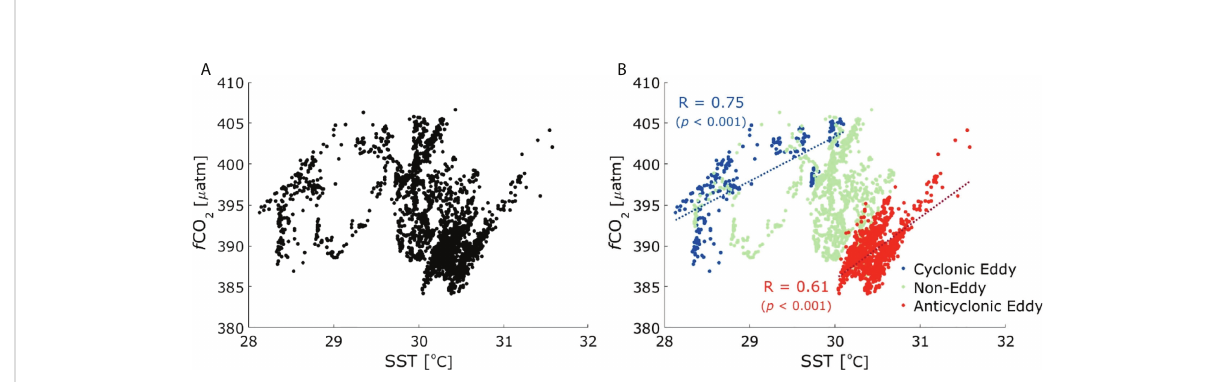
FIGURE 4 Plots of f CO 2 vs. SST in the study region (A) and three subregions (B) ; cyclonic eddy, anticyclonic eddy, and non-eddy. Blue dots indicate a cyclonic eddy, green dots are non-eddy region, and red dots are an anticyclonic eddy. Dotted lines indicate linear regressions in the cyclonic and anticyclonic